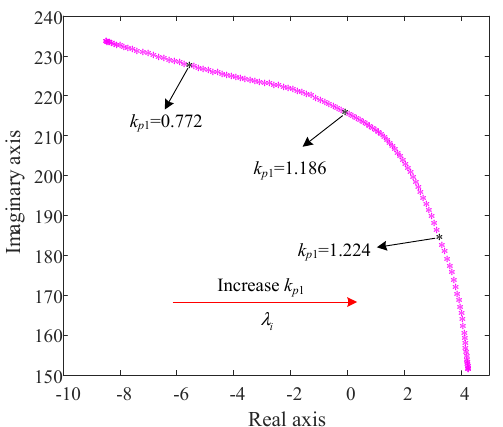
Figure 6. Trajectories of oscillation mode associated with the poorest damping eigenvalue λ i when k p 1 increased.